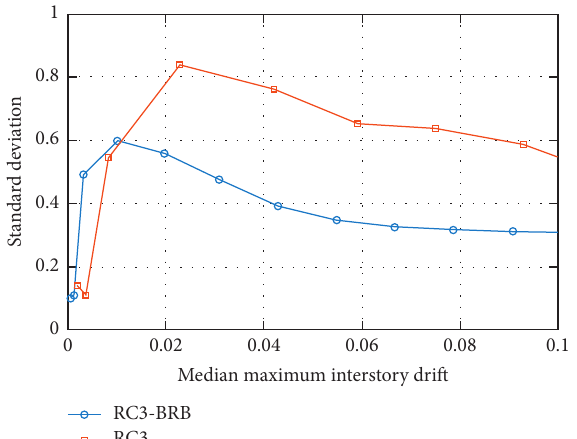
Figure 5: Comparison of the standard deviation at different performance levels in terms of the median maximum interstory drift value for the buildings RC3 and RC3-BRB.